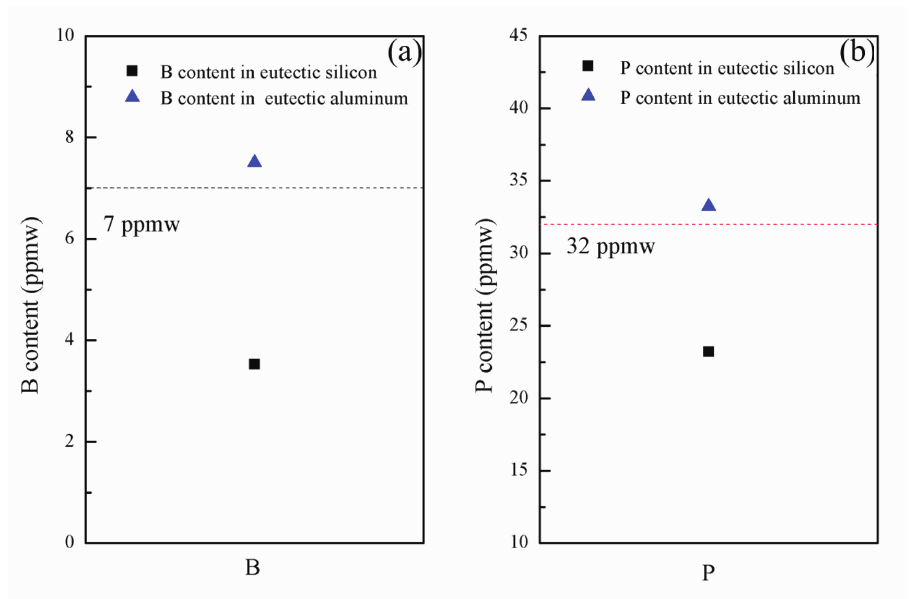
Figure 7: The boron and phosphorus distributions in sample series 2 No.4, (a) boron distribution, (b) phosphorus